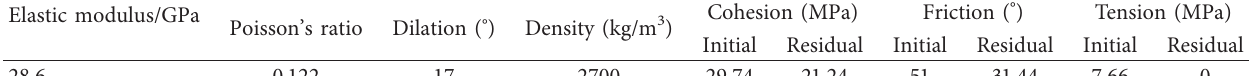
Figure 6: Schematic diagram of Beishan granite model [14]. Table 4: Mechanical parameters of Beishan granite.